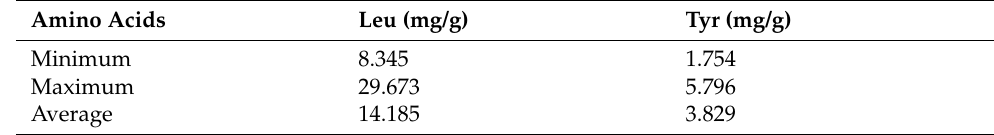
Table 1. Contents of Leu and Tyr in Golden Tartary buckwheat leaves. Amino